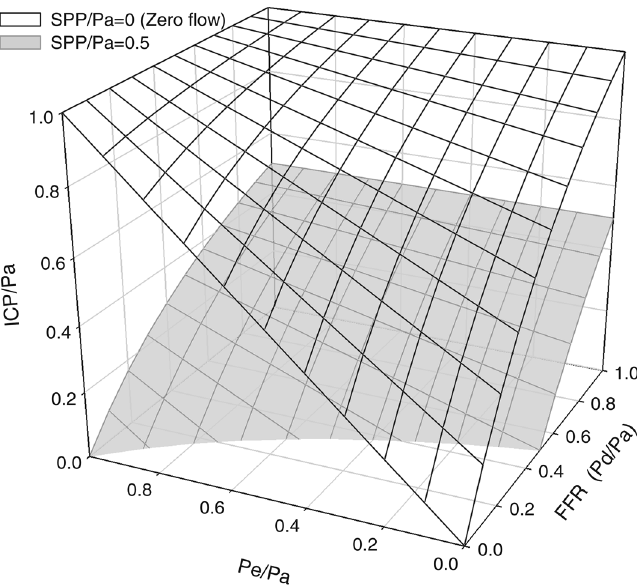
Figure 7. Surfaces indicating zero and 50% (of arterial pressure Pa) intracranial segmental perfusion pressure— the difference between intracranial inflow pressure Pd and intracranial pressure ICP (SPP = Pd–ICP); SPP surfaces were calculated from the intra-extracranial blood flow model expressing ICP from the fixed SPP value. Surfaces reflect all possible combinations of FFR, ICP, and Pe leading to SPP being either 0 or 50% of Pa, where FFR = Pd/Pa is fractional flow reserve. Extracranial outflow pressure (Pe), ICP, and SPP—are all scaled to the arterial pressure Pa. Intra-extracranial conductances were assumed to be equal (relative extracranial conductance Ge = 0.5). Autoregulation was presumed absent. Zero SPP surface indicates the absence of intracranial flow. When FFR or Pe is 1, ICP has to reach arterial pressure to make SPP zero, thus arresting blood flow. When FFR is low, intracranial blood flow stops with lower ICP due to intra-extracranial steal, which can be reversed by increasing extracranial outflow pressure. The specific location of the zero flow condition suggests most effective resuscitative measures to increase SPP to 50% of Pa: with ICP close to arterial pressure, the only way to increase SPP is to lower ICP, however, if zero flow conditions exist at relatively low ICP, addressing extracranial stenosis is more important, while at the same time extracranial outflow manipulation could be used for temporary reversal of the intra-extracranial